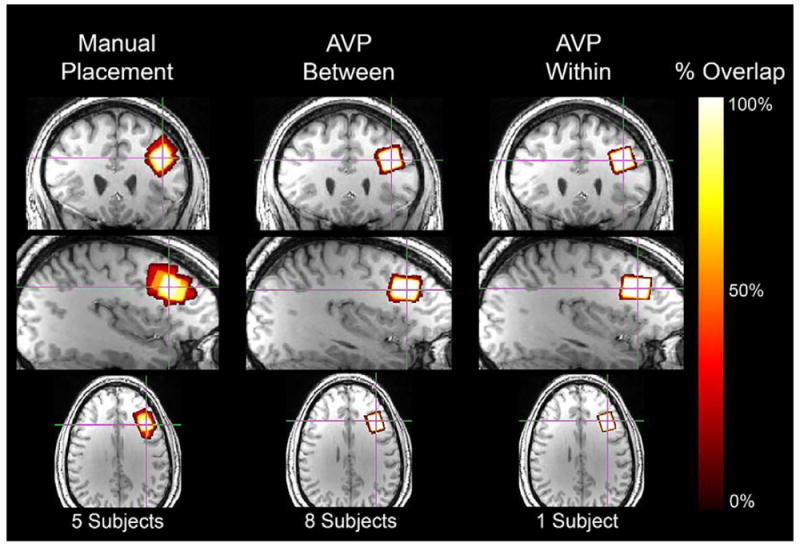
Orthonormal slices of 3D geometric voxel overlap in template space are depicted.
Left panel: Voxel overlap across subjects using manual voxel placement (n
= 5) is depicted. Center panel: Voxel overlap across subjects using AVP
(n = 8; baseline) is depicted. Right panel: Voxel overlap within a
single subject across timepoints using AVP is depicted. Note: white indicates
complete voxel overlap, yellow-orange gradient indicates incomplete voxel
overlap, and red indicates no voxel overlap.